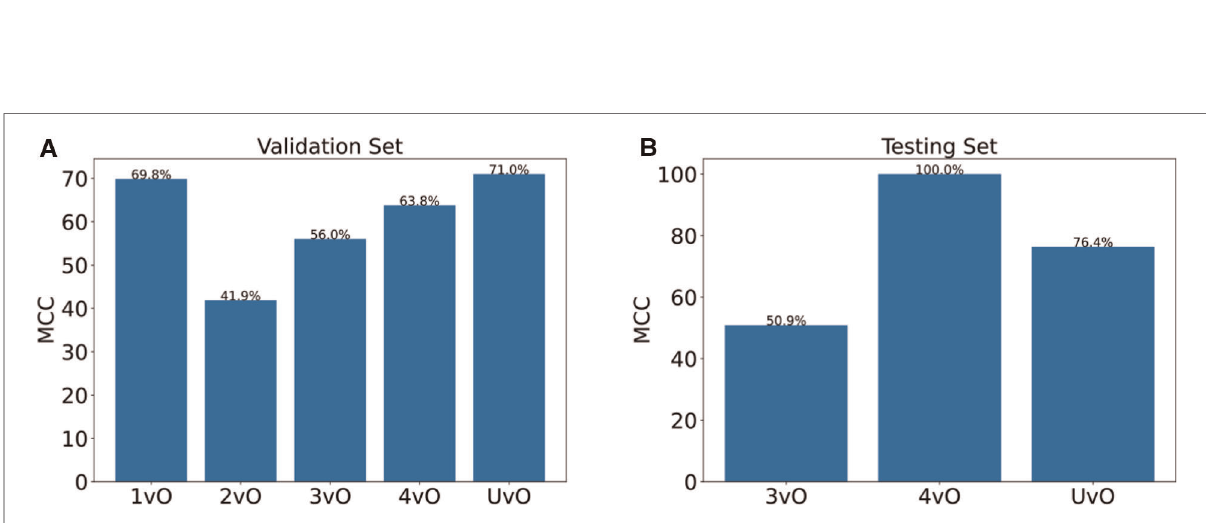
FIGURE 2 Evaluation of the classi fi cation results of the PI stages. Stage 1 (1), stage 2 (2), stage 3 (3), stage 4 (4), and unstageable ( U ) of the trained YOLOv4 model by computing the confusion matrix and corresponding Sensitivity (TP/TP+FN) and Speci fi city (TN/TN+FP) of ( A ) validation set of 144 photos, and ( B ) testing set of 10 photos. 1vO: Stage 1 vs. Others; 2vO: Stage 2 vs. Others; 3vO: Stage 3 vs. Others; 4vO: Stage 4 vs. Others; UvO: Unstageable vs.